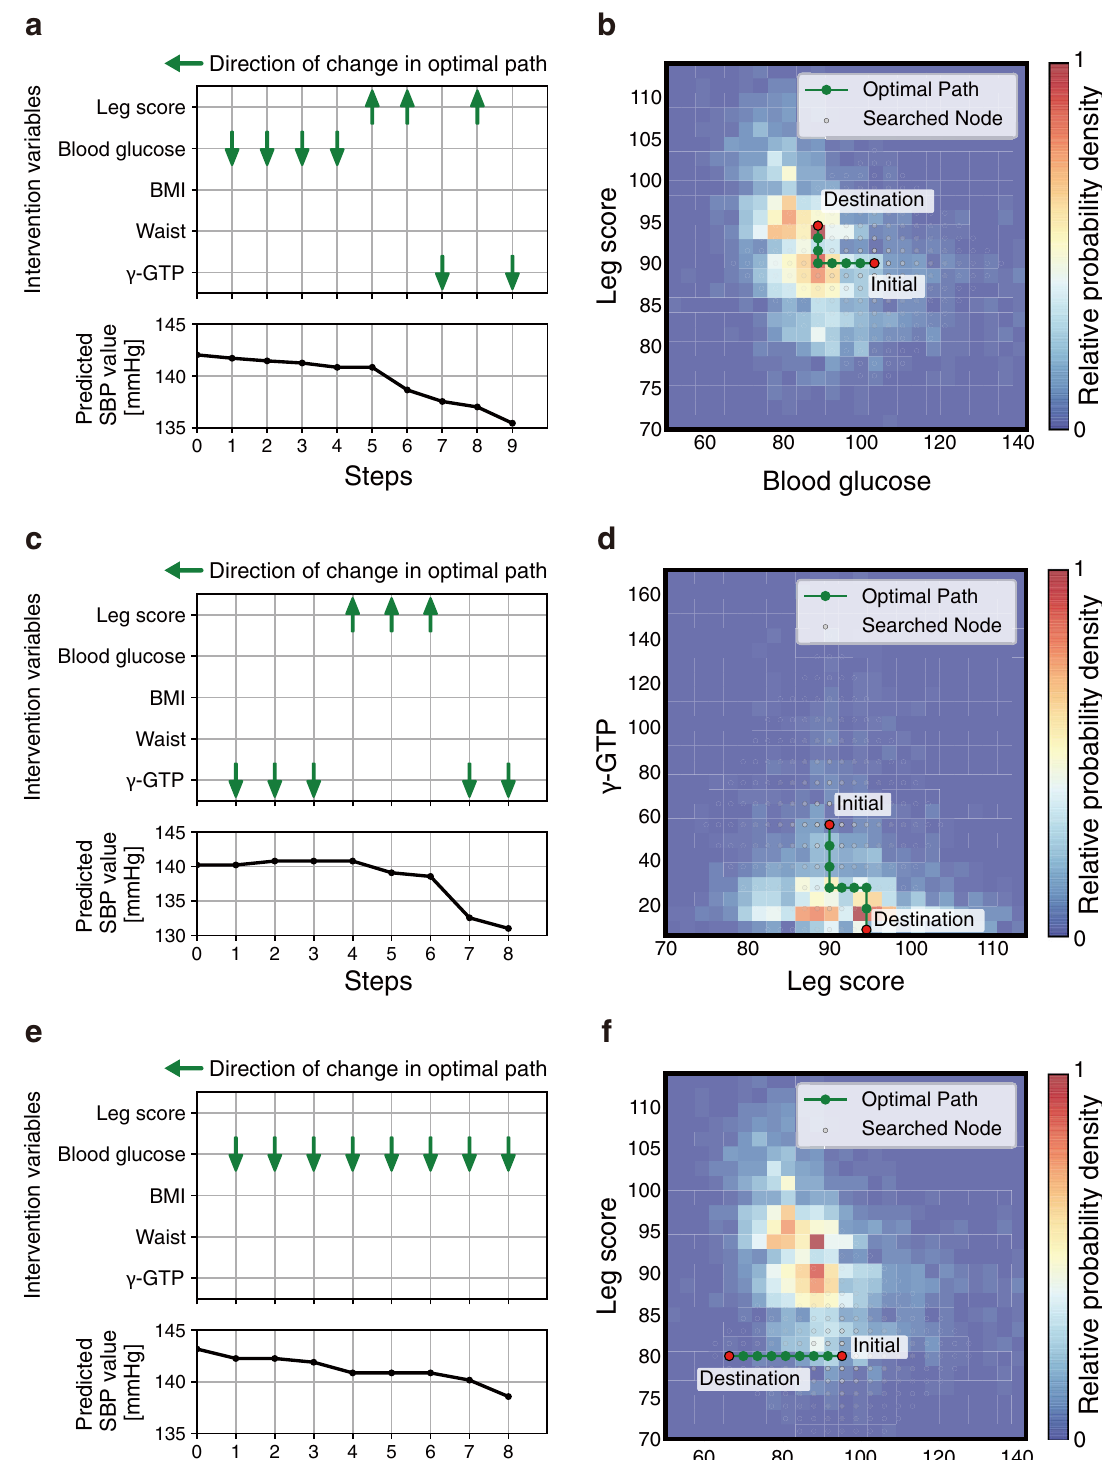
stochastic surrogate model based on multiple imputed RFE- selected features and predicted SBP. The lowest WBIC value was obtained when the number of mixture components was fi ve (Fig. 5c). Path planning was performed with this stochastic surrogate model. Regarding the intervention variables in path planning, we examined two patterns for selection methods: data- driven selection and hypothesis-driven selection. NATURE COMMUNICATIONS| (2021) 12:3088